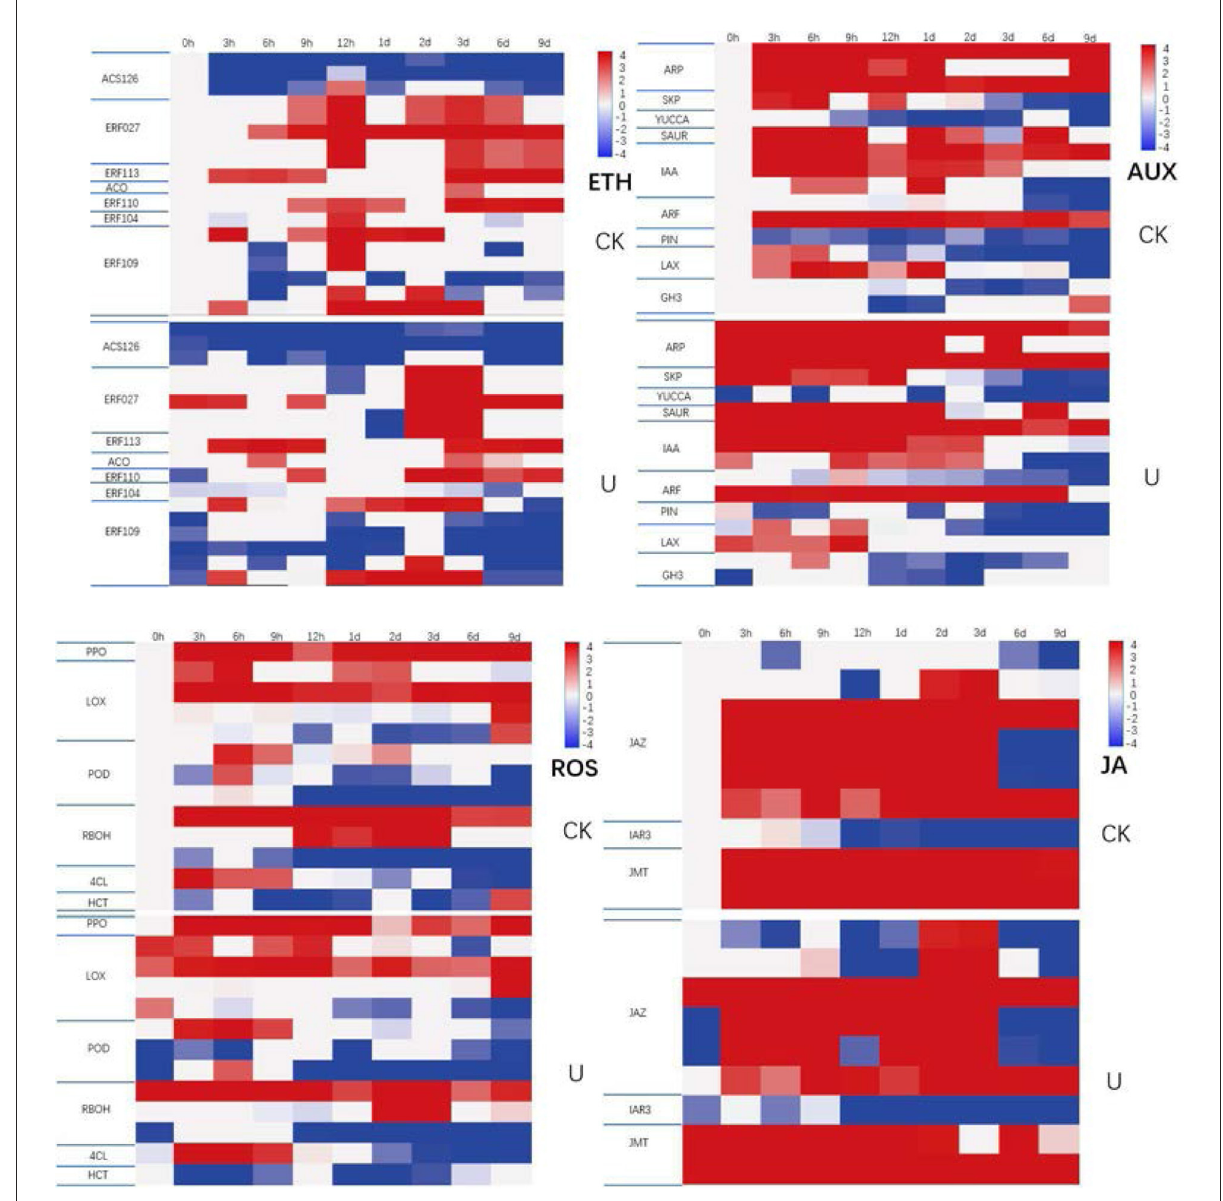
FIGURE8 Expression profile of genes involved in ROS, hormone metabolism and signaling pathways and transcription factor during storage as indicated by heatmap. The normalized expression value of each gene in each sample was shown in colored blocks. Red color represents the higher expression level of the gene in the sample, and blue represents the lower expression level. The specific expression level was shown in the upper left color bar. DEGs (differentially expressed genes) were defined with fold change ≥ 2 and a p -adjust < 0.05 as forward descriptions.